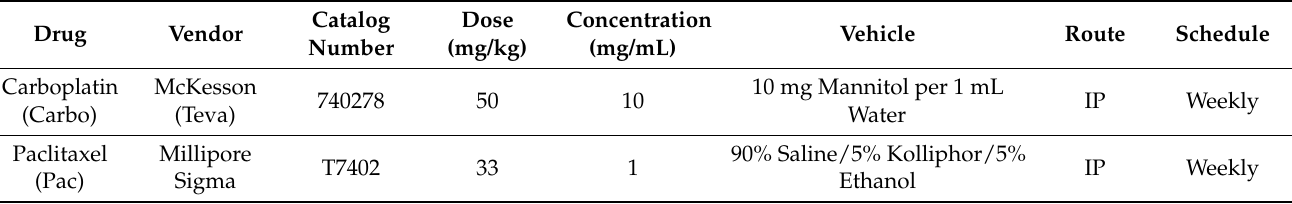
Table 2. Treatment schedule of preclinical trial of TNBC